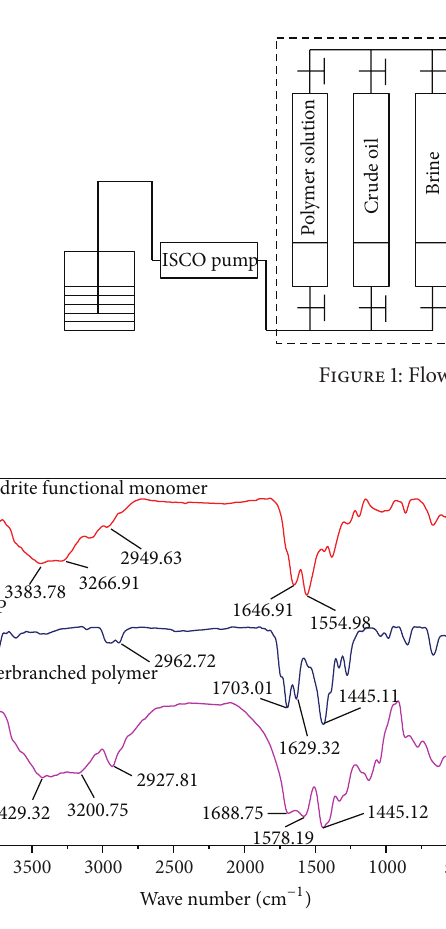
Figure 2: IR spectra of the dendrite functional monomer, NVP, and hyperbranched